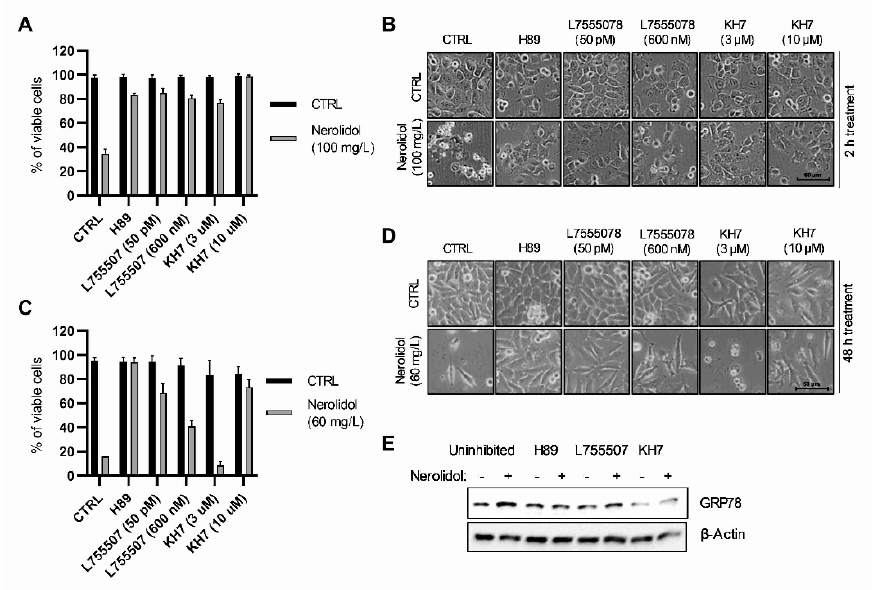
Figure 4. Both nerolidol-induced cell death pathways include cAMP-dependent signal transduction through β -adrenergic receptors, PKA, and soluble adenylyl cyclases. ( A ) Cell viability of T24 cells pre-treated with H89 (50 nM), L755507 (50 pM and 600 nM), and KH7 (3 and 10 µ M) for 1 h and then treated with 100 mg/L of nerolidol for 2 h determined by cell counting and trypan blue staining. Cell counts were normalized to control cells. ( B ) Cell microscopy images of T24 cells pre-treated with H89 (50 nM), L755507 (50 pM and 600 nM), and KH7 (3 and 10 µ M) for 1 h and then treated with 100 mg/L of nerolidol for 2 h. ( C ) Cell viability of T24 cells pre-treated with H89 (50 nM), L755507 (50 pM and 600 nM), and KH7 (3 and 10 µ M) for 1 h and then treated with 60 mg/L nerolidol for 48 h determined by cell counting and trypan blue staining. Cell counts were normalized to control cells. ( D ) Cell microscopy images of T24 cells pre-treated with H89 (50 nM), L755507 (50 pM and 600 nM), and KH7 (3 and 10 µ M) for 1 h and then treated with 60 mg/L of nerolidol for 48 h. ( E ) T24 cells treated with H89 (50 nM), L755507 (50 pM), and KH7 (10 µ M) for 1 h before administration of 60 mg/L nerolidol for 24 h. Immunostaining of GRP78 was used as a marker of ER stress activation. The uncropped blots and molecular weight markers are shown in Supplementary File